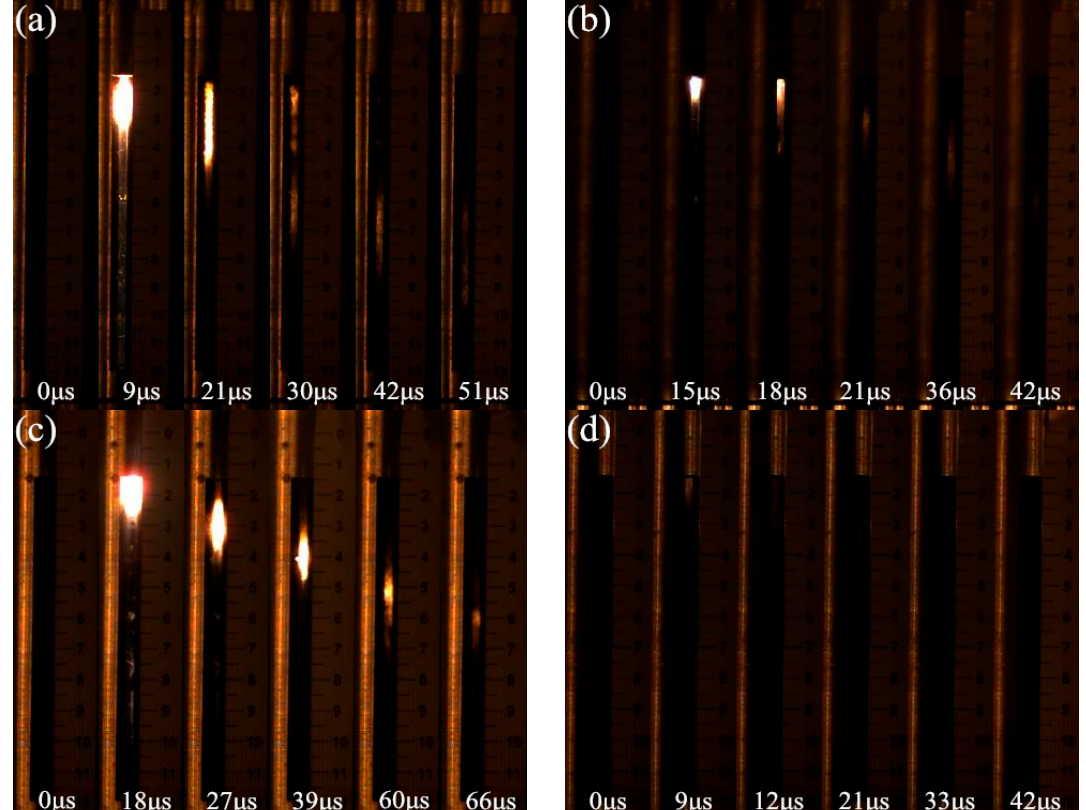
Figure 7. High-speed video sequences of partial tests. ( a ) Test No. 2; ( b ) Test No. 5; ( c ) Test No. 8; and ( d ) Test No. 10.